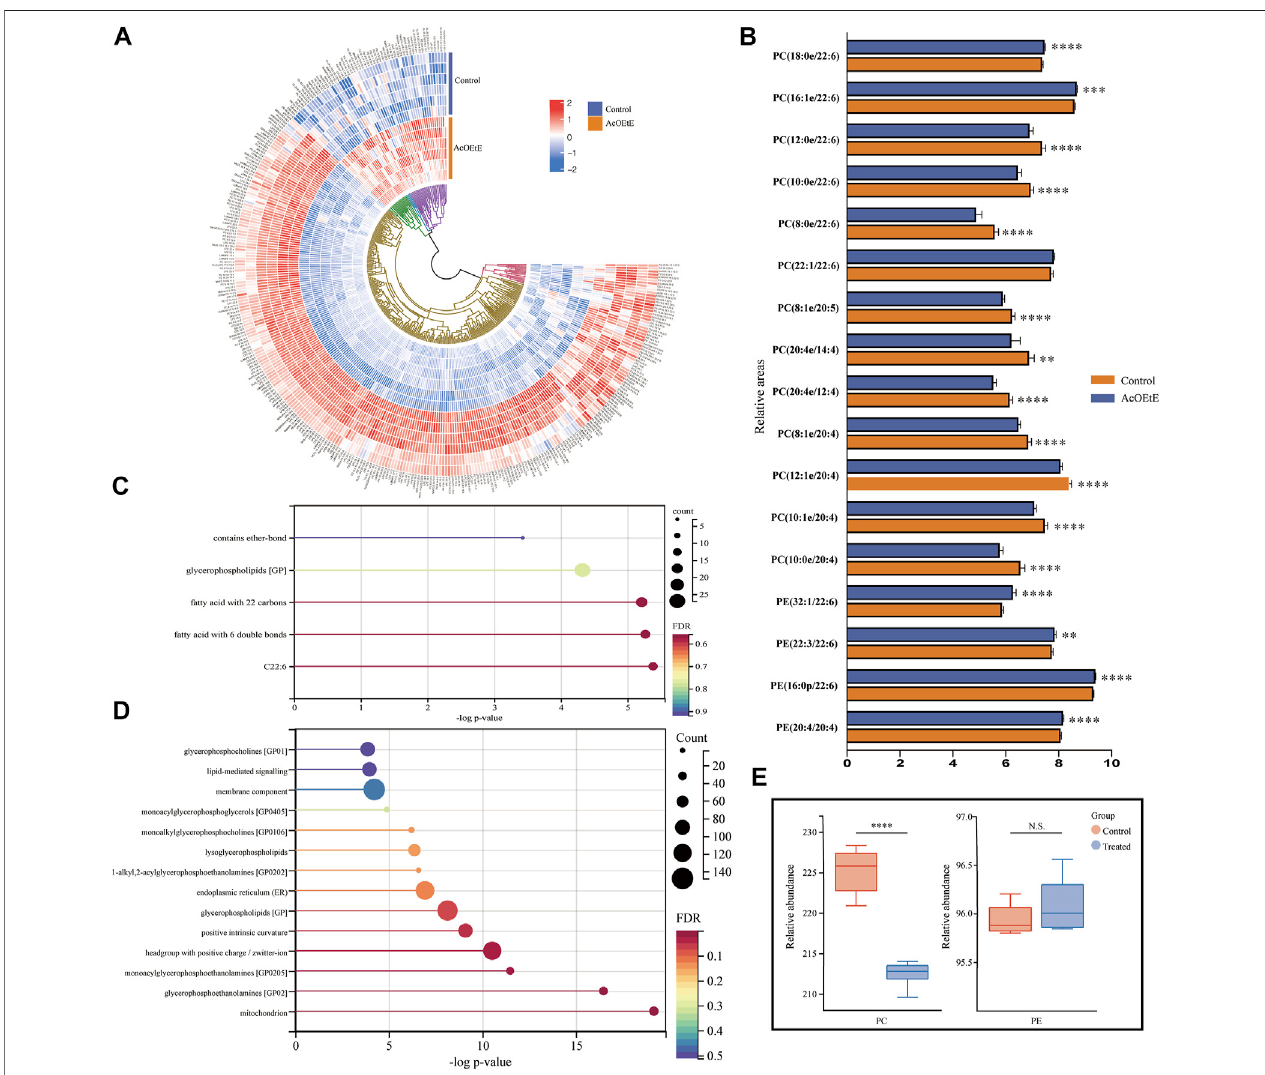
FIGURE3| AnalysisofabnormallipidregulationbyAcOEtEinzebra fi shlarvae (A) Heatmapof325lipidsinthecontrolandAcOEtEgroups.Theredandbluecolors indicatetheincreasedanddecreasedlevels,respectively (B) Relativeintensityanalysisofsubclassescontainingeicosatetraenoicacidordocosahexaenoicacidbetween the control and AcOEtE groups (C) LION-term enrichment analysis of all up-regulated lipids in the AcOEtE group compared to the control group (D) LION-term enrichmentanalysisofalldown-regulatedlipidsintheAcOEtEgroup (E) PCsandPEsincontrolandAcOEtEgroupsshowedariseintotalconcentration.* p < 0.05, ** p < 0.01 compared with the control